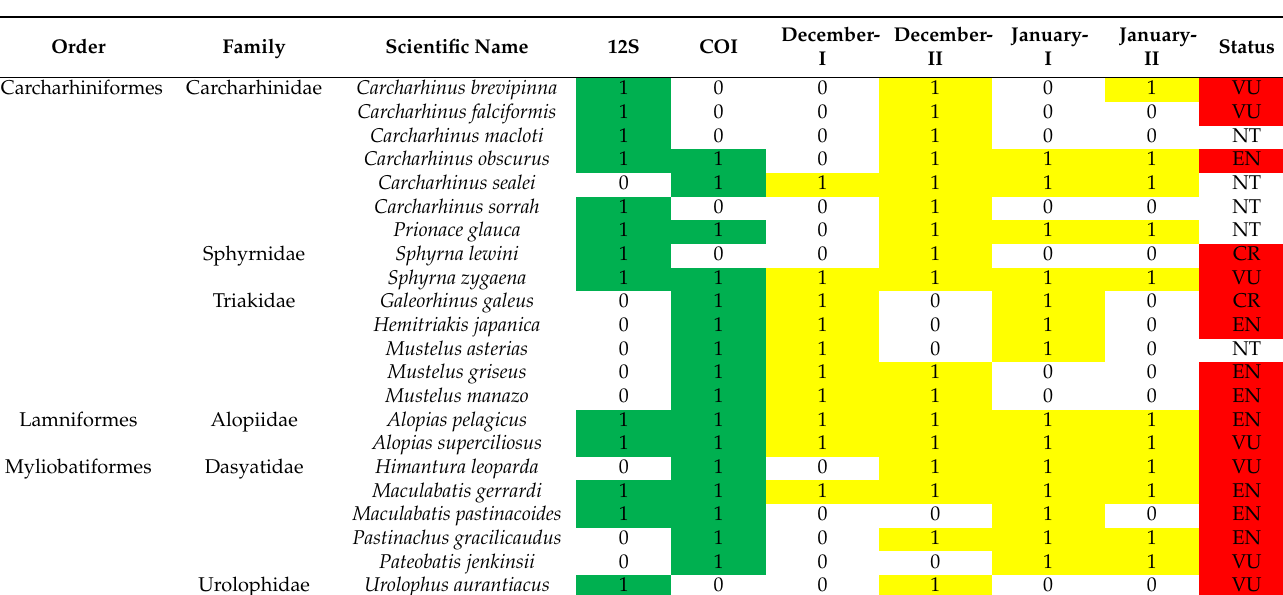
Table 4. List of chondrichthyan species detected in this